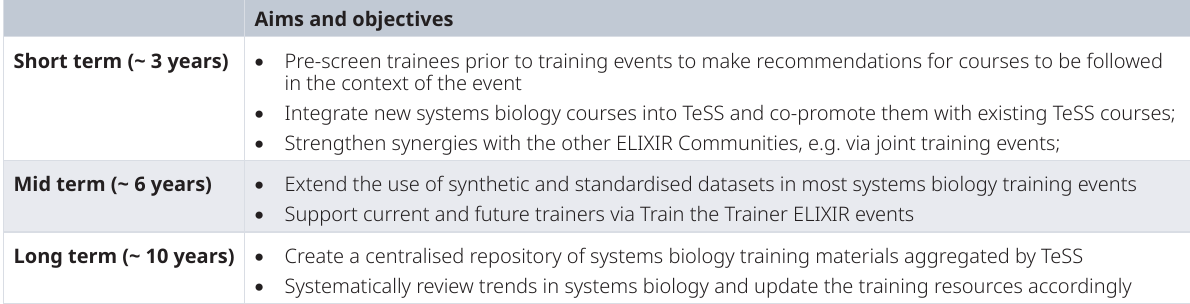
Table 6. Breakdown of short, mid and long term objectives for Capacity building/Training theme.